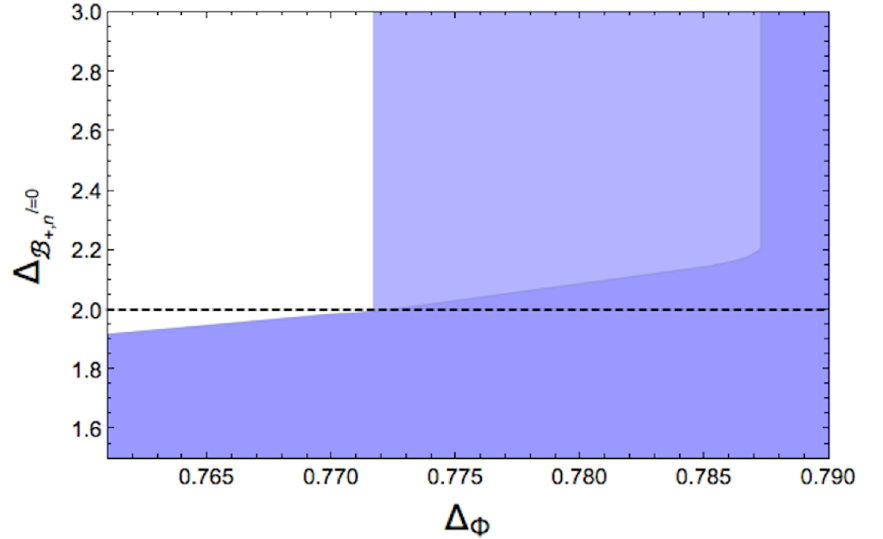
. F j =1 / 2 + ,n ≥ ∆ unitarity . The jump happens precisely at F l =1 + ,n ≥ ∆ unitarity +1 . 2